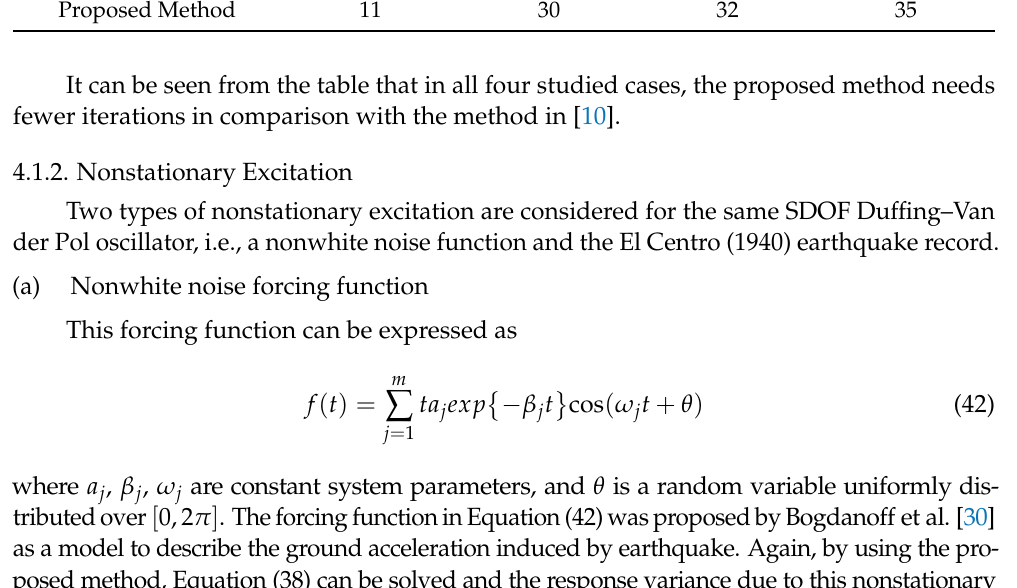
Figure 5. Mean square displacement response due to stationary excitation. ( γ = 10.0, μ = 10.0).